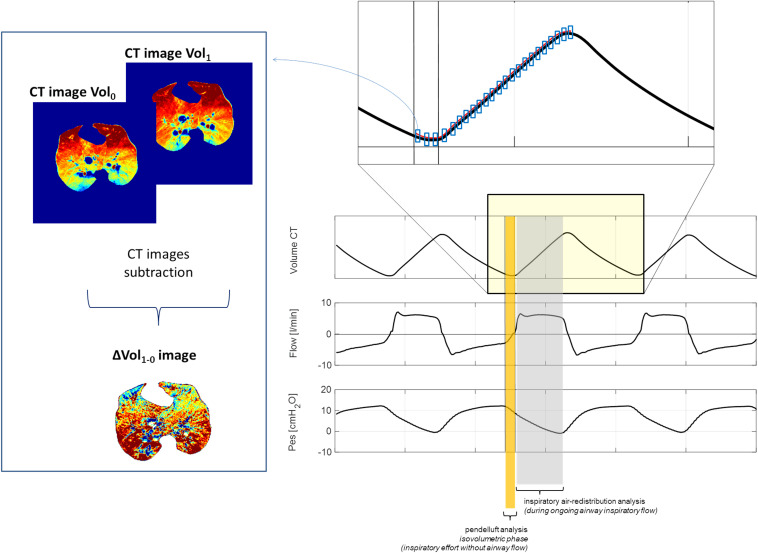
Methods. Left panel: Methods to obtain delta-volume images. Right panel: Isovolumetric flow-independent phase defined as pendelluft (yellow rectangle) of the inspiration and the flow-dependent phase of the inspiration (gray rectangle).